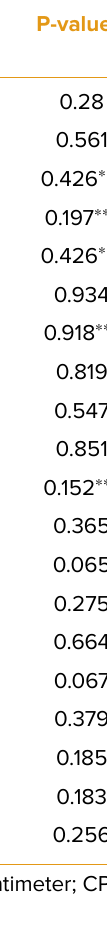
Table 1. The mean and standard deviation (SD) of indices in different gazes according to sex